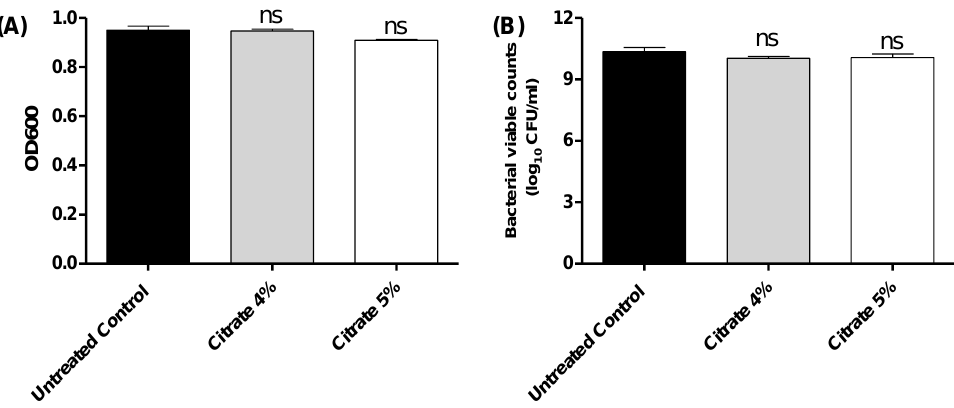
Figure 1. The effect of sodium citrate at 4% or 5% on the S. marcescens growth. There was no significant effect of citrate at tested concentrations on ( A ) the optical densities of bacterial growth, ( B ) bacterial counts. One-way ANOVA test was employed to assess significance; ns, non-significant: p > 0.05.